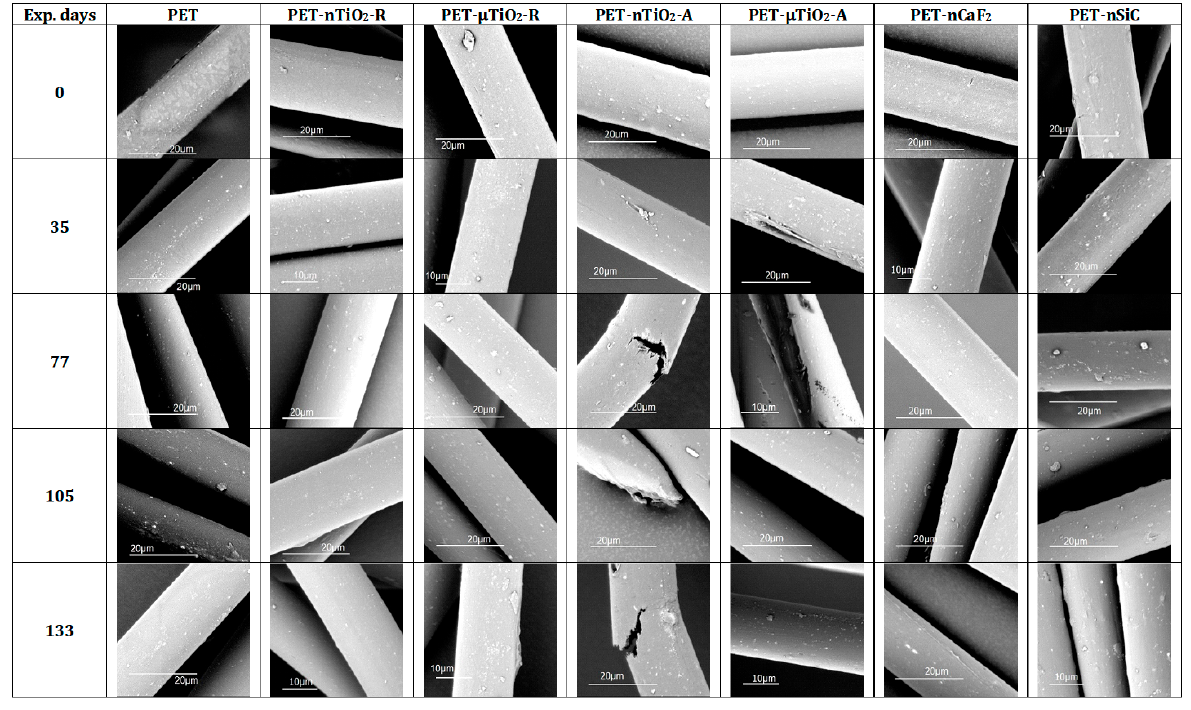
Figure 11. Micrographs of yarns.